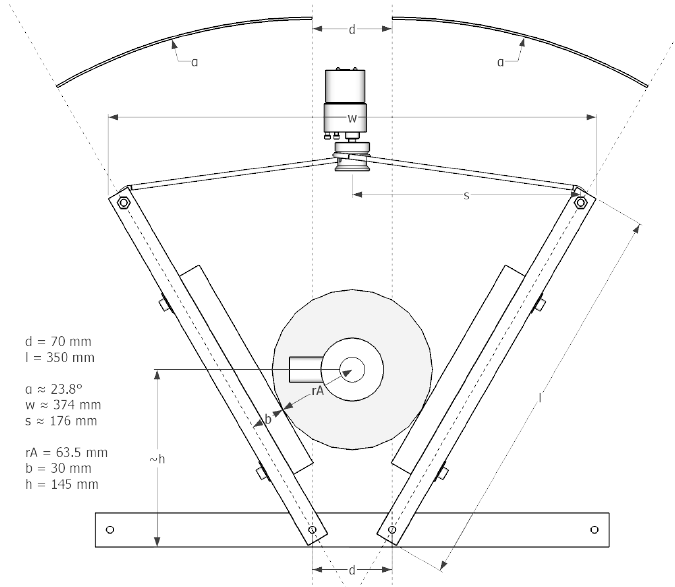
Figure 17. Schematic of the eARM system with minimum compresion showing the bag-valve resuscitator. The design will require adjustments.